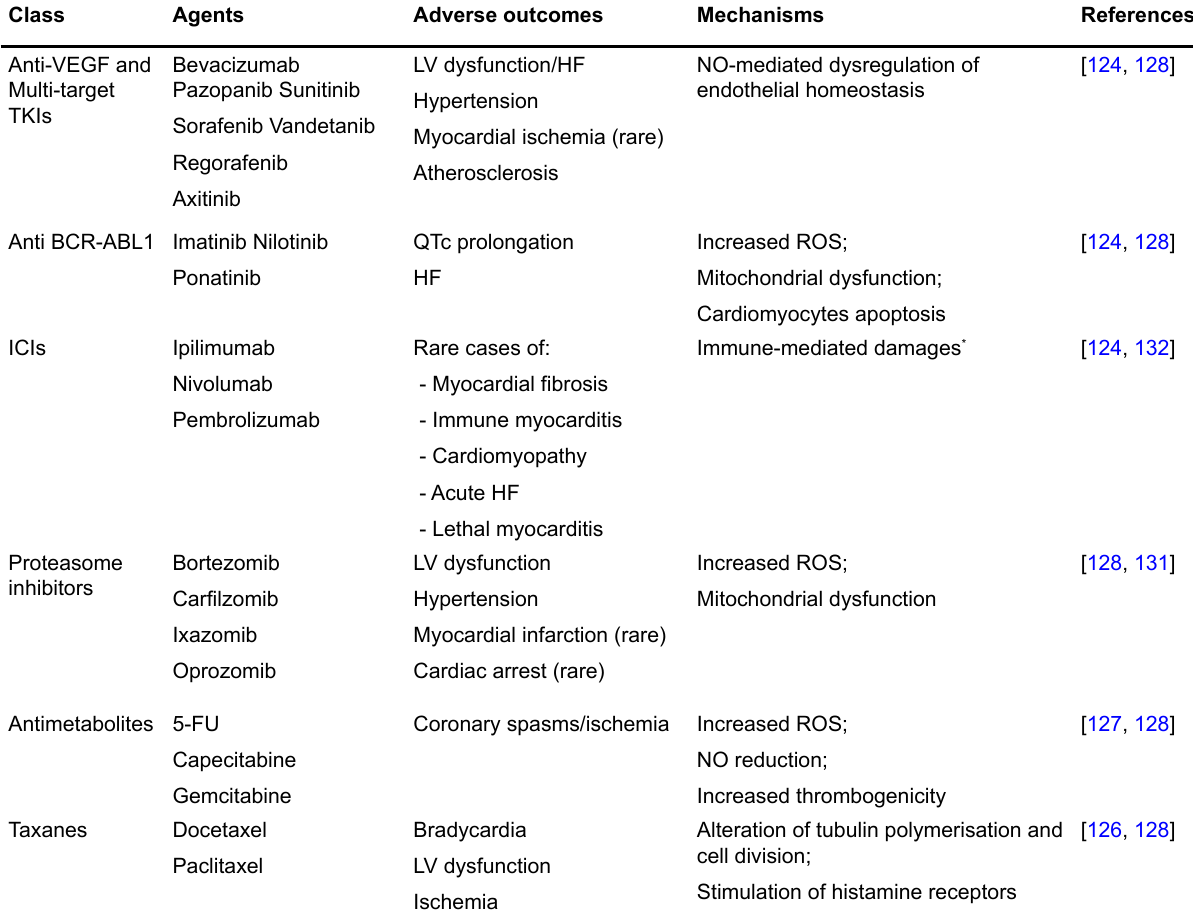
Table 2. Anticancer drugs effects on renal, retinal, neuronal and cardiovascular events ( continued )